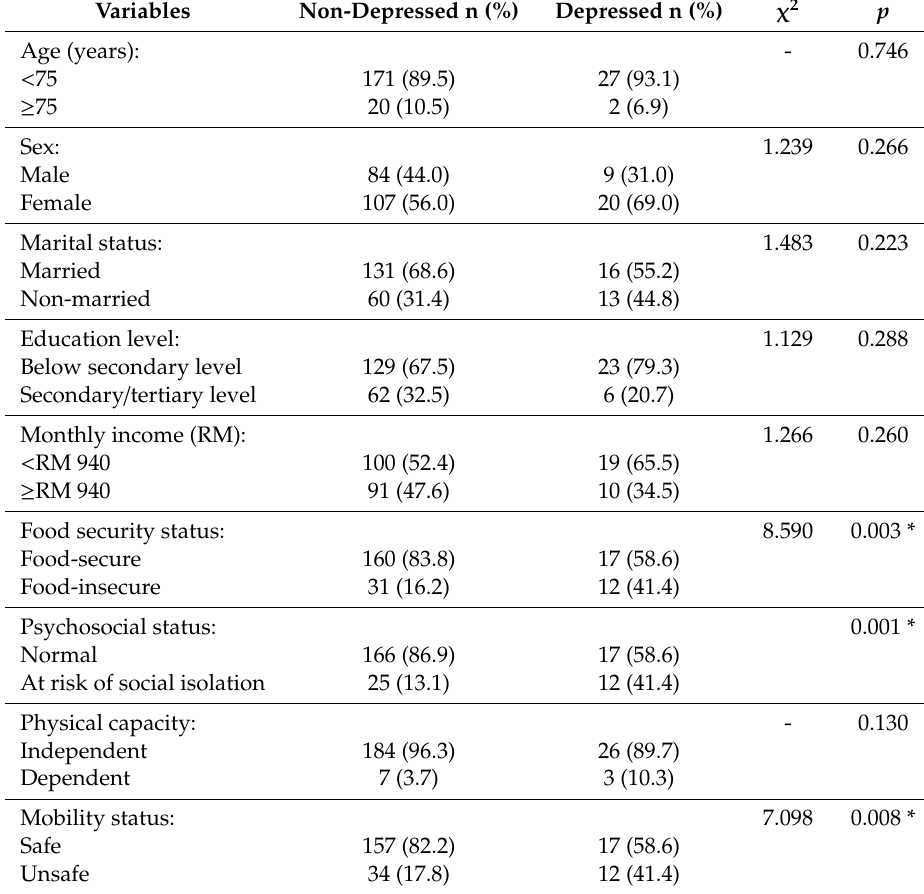
Table 2. Associations between demographic, food security, and functional status and depression